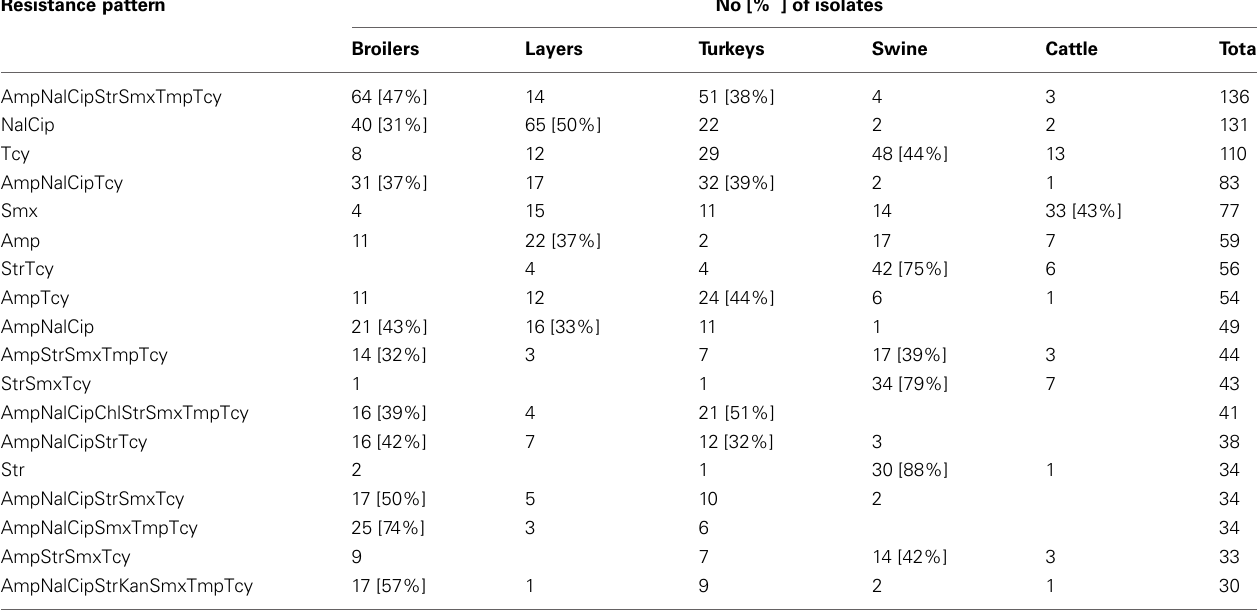
* Percentage of the isolates representing a profile is shown if ≥ 30%.